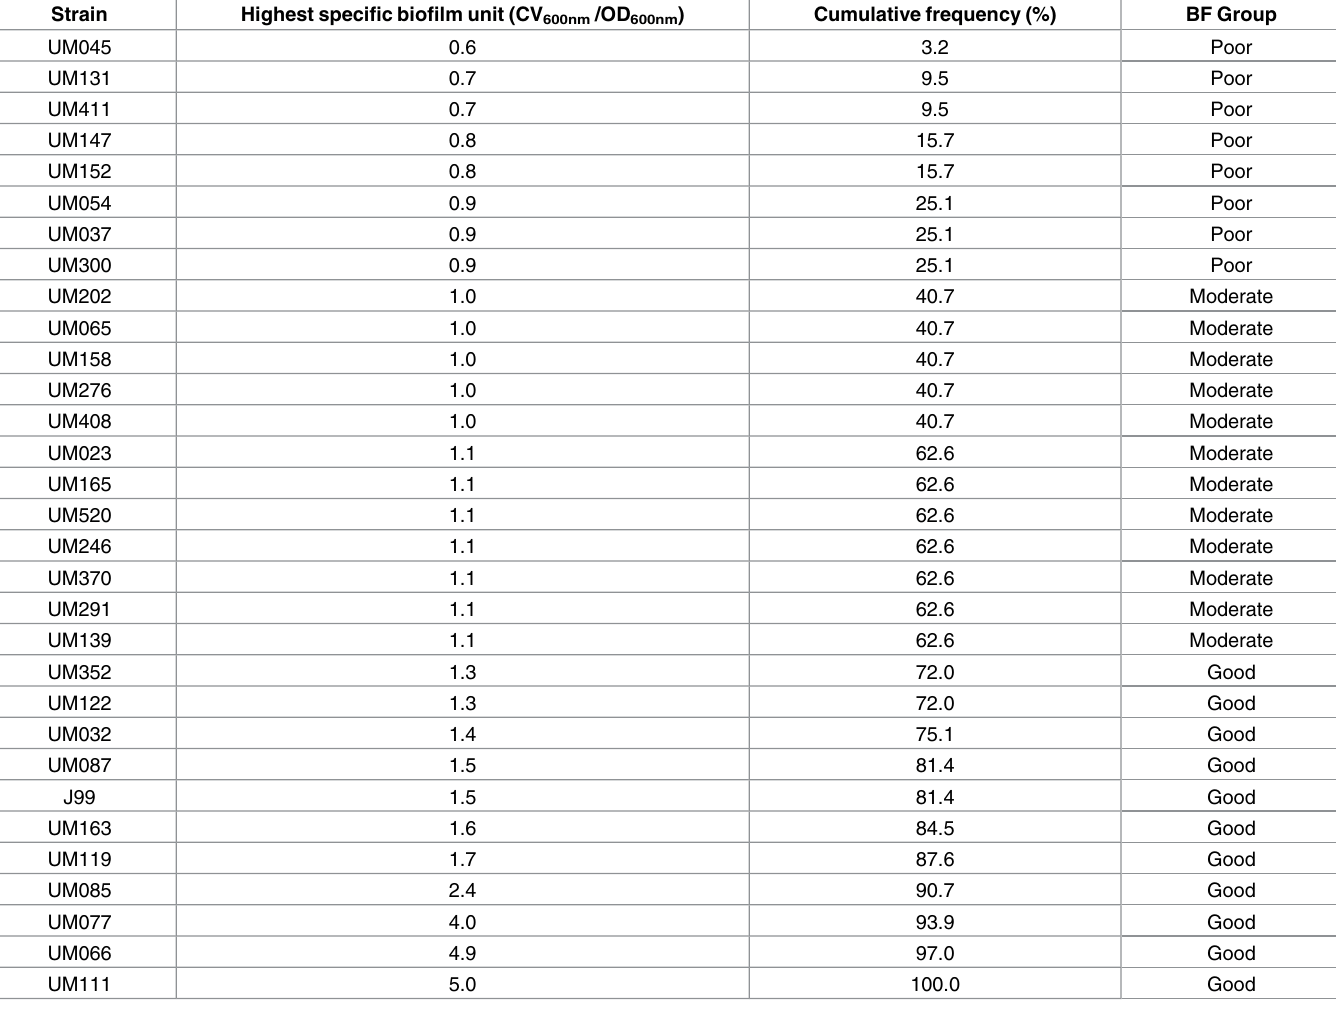
Table 3. Classification of H . pylori strains based on highest specific biofilm unit. One-way ANOVA was used to demonstrate statistically significantdif- ferences in highest specific biofilm unit betweenpoor, moderate and good biofilm formers (p-value= 0.001).